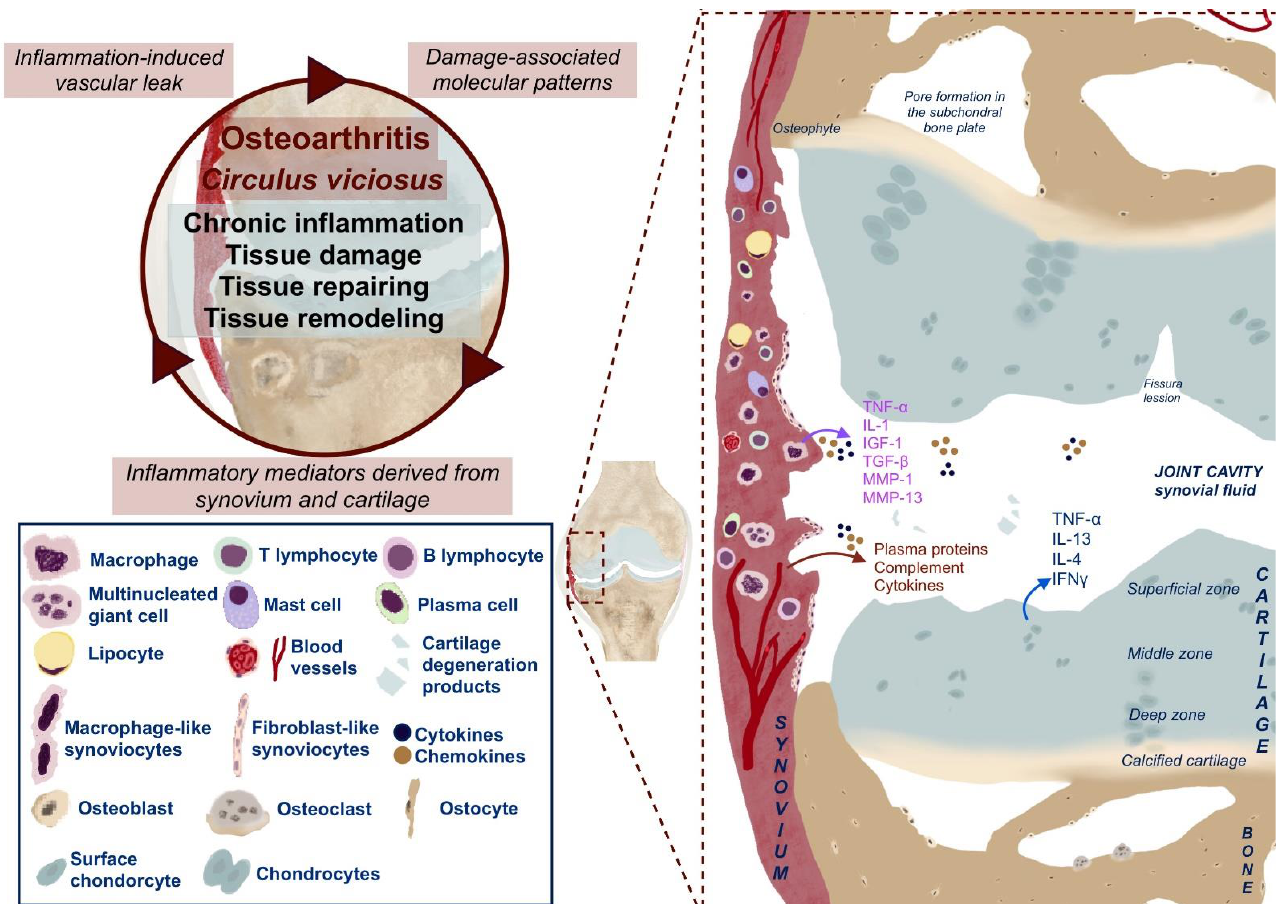
Figure 3. Signaling pathways and structural changes associated with the development of osteoar- thritis.